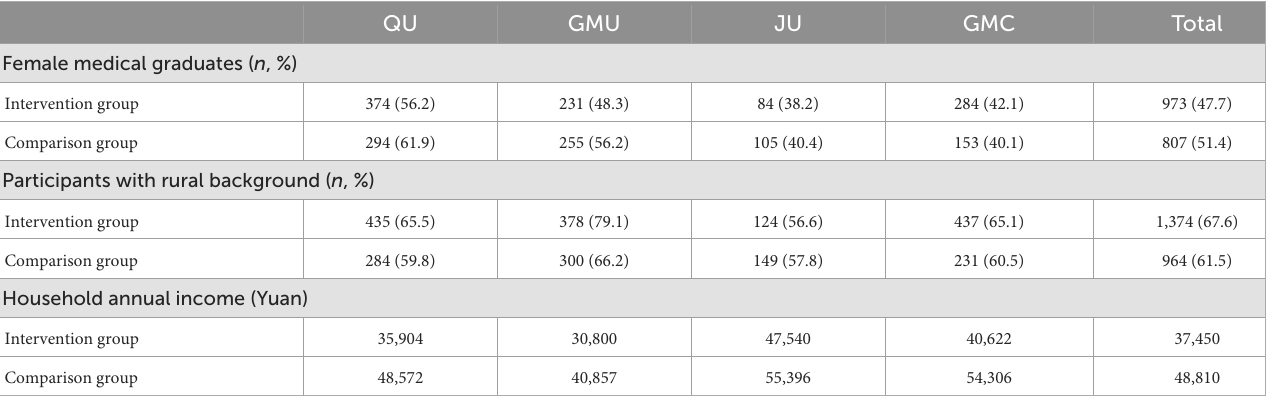
TABLE 1 Demographic information of the study participants.